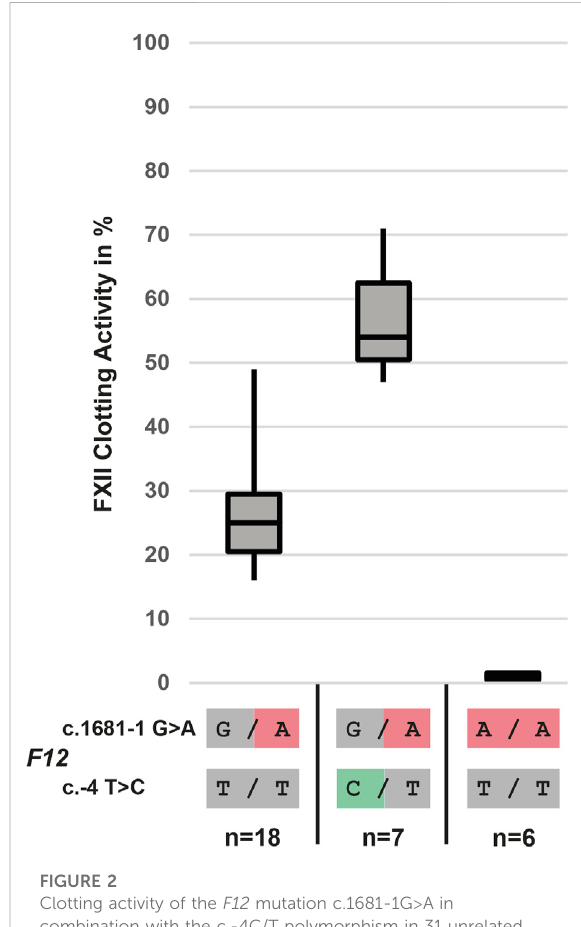
FIGURE 2 Clotting activity of the F12 mutation c.1681-1G > A in combination with the c.-4C/T polymorphism in 31 unrelated individuals illustrating the loss of FXII